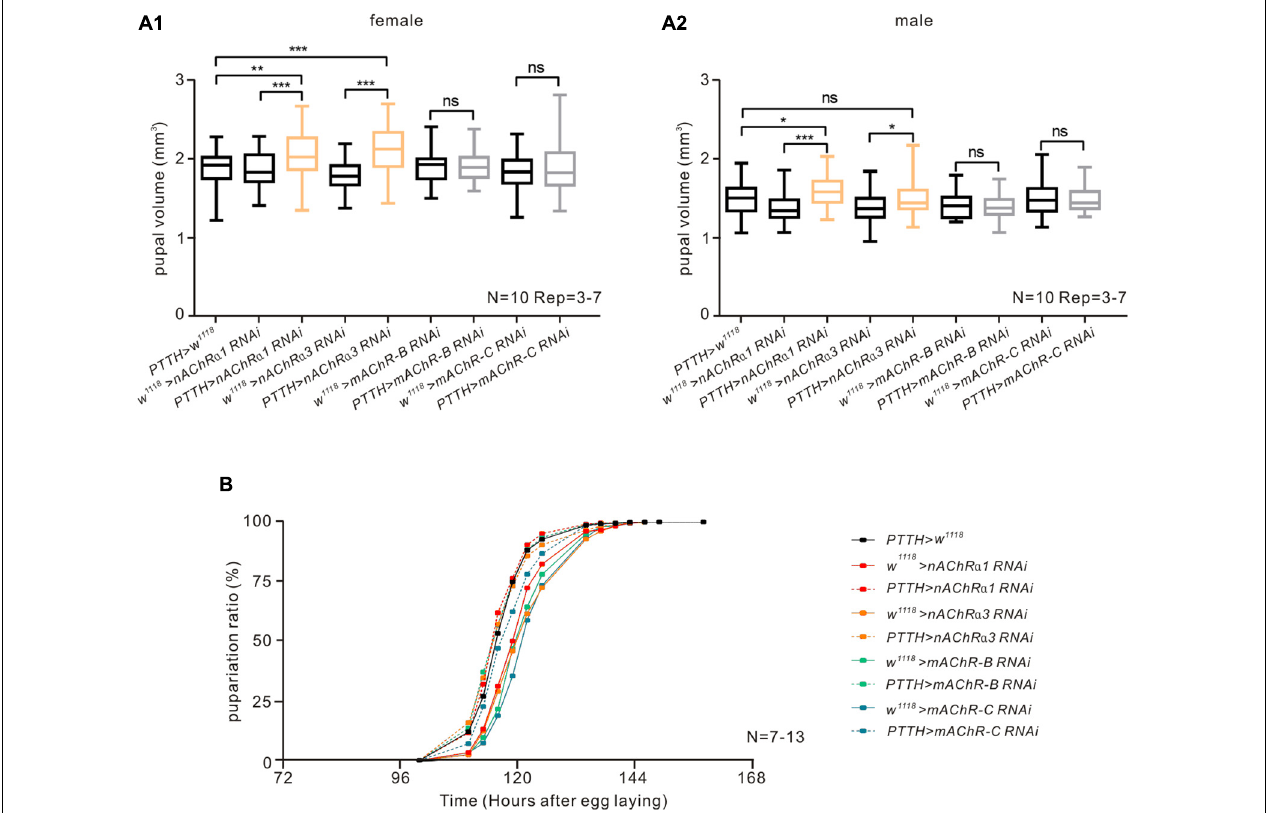
FIGURE 3 | nAChRs on PTTH neurons have a negative effect on pupal volume but do not influence pupariation timing in Drosophila . (A) Downregulating the expression of nAChR α 1 or α 3 subunit in PTTH neurons caused an increase in pupal volume but no obvious changes in pupariation timing in both female (A1) and male (A2) flies. There was no change in pupal volume when downregulating the expression of mAChR-B/C subtypes in PTTH cells. The orange bars represent experimental groups with significant differences. We measured the volume of 10 female pupae and 10 male pupae in every experiment and repeated the experiment 3–7 times. * p < 0.05, ** p < 0.01, *** p < 0.001; ns, not significant p > 0.05. (B) Downregulating the expression of different nAChR subunits ( α 1, α 3) or mAChR subtypes (mAChR-B or mAChR-C) in PTTH neurons had no influence on pupariation timing. In the pupariation timing curves, different colors represent different receptor RNAi control groups (solid lines) and experimental groups (dashed lines). The experiment in all groups was repeated 7–13